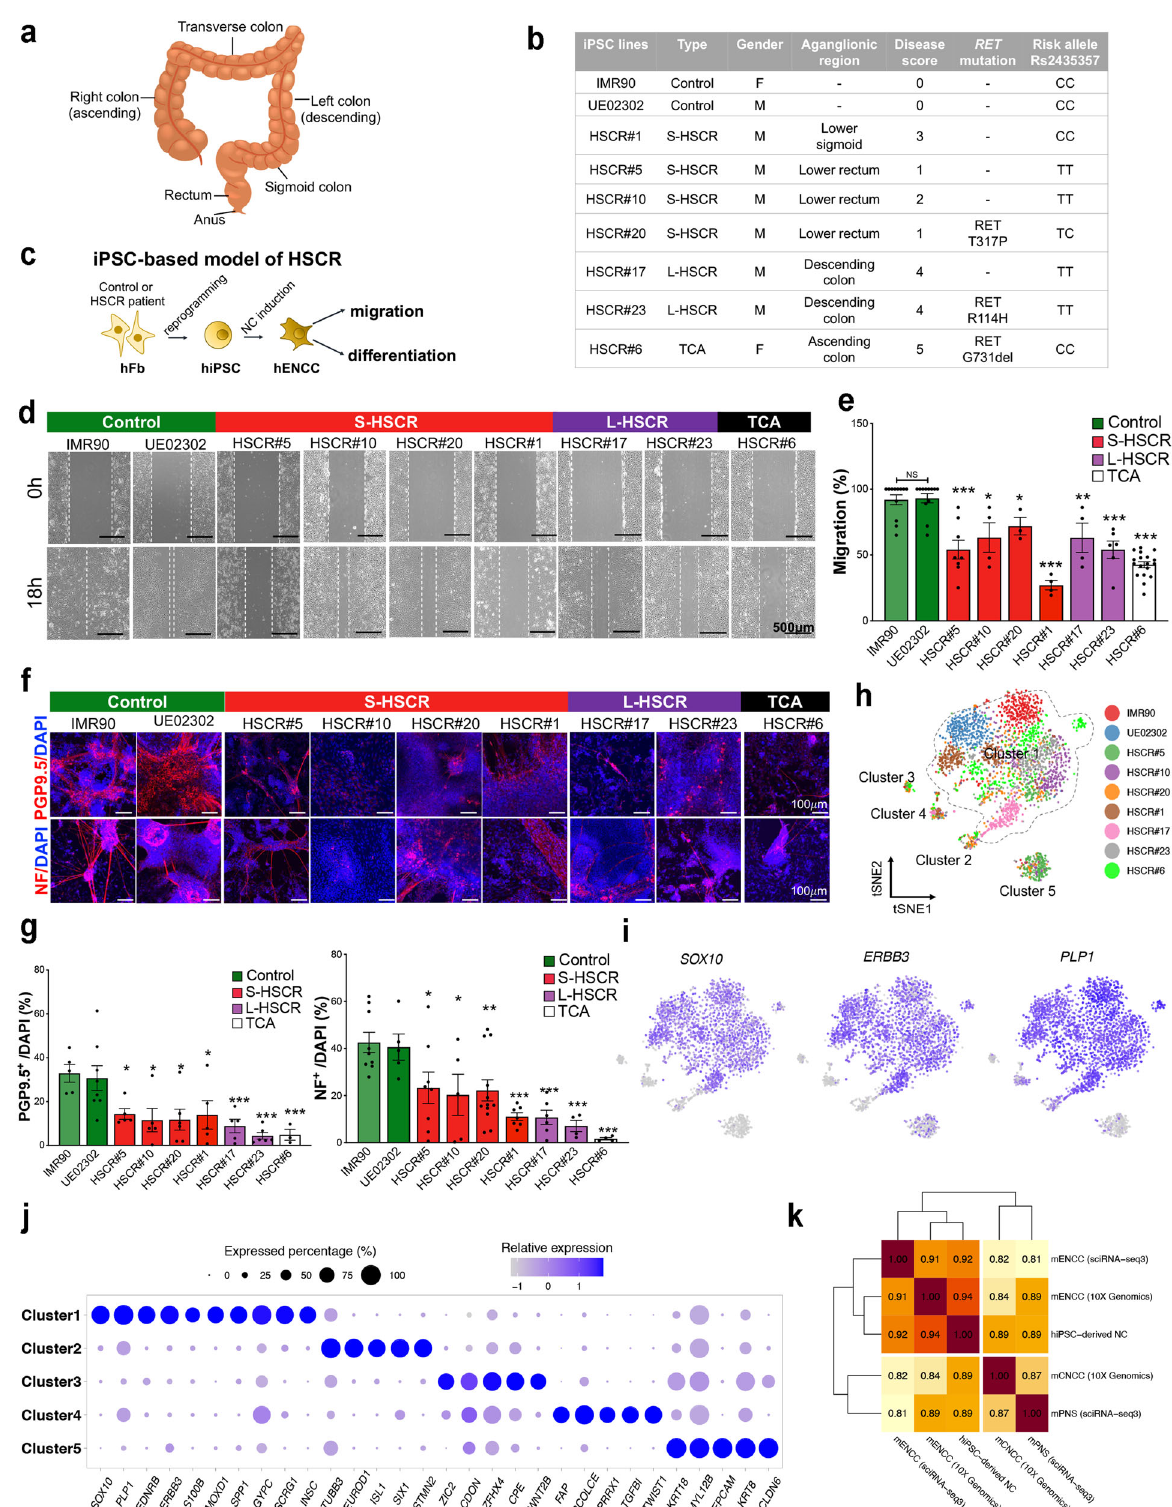
Strati fi cationof HSCR patients andreconstruction